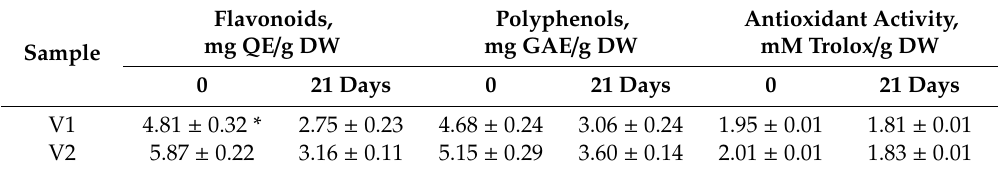
Table 2. Storage stability of microencapsulated phenolic compounds in soft